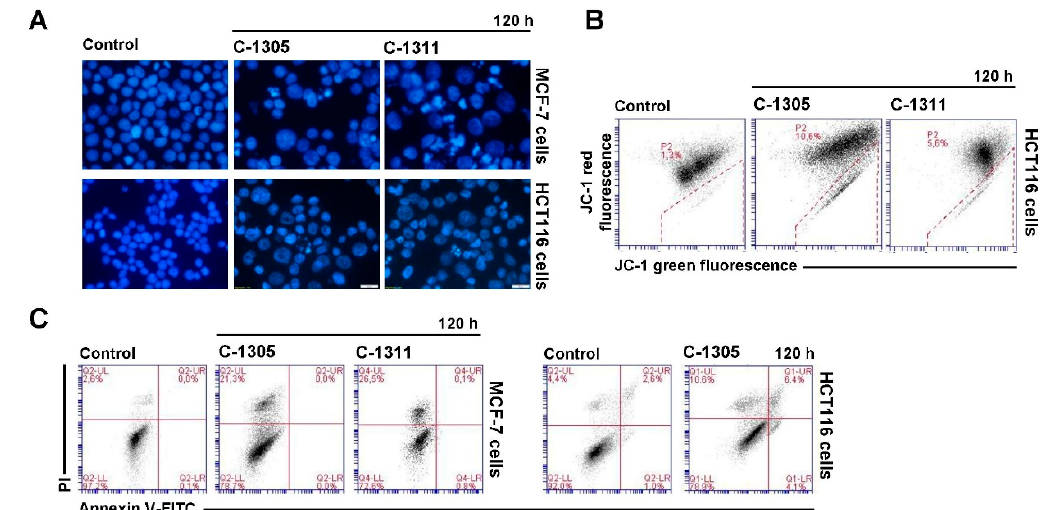
Figure 6. Cellular response of MCF-7-EV and HCT116-EV cells. ( A ) Representative pictures of changes in nuclear morphology of MCF-7 and HCT116 cells treated with IC 80 or IC 90 dosage, respectively, of C-1305 and C-1311 compounds. Cells were stained with 4 ′ ,6-diamidino-2- phenylindole (DAPI; 1 mg/mL) and visualized under fluorescent microscope (400× magnification); ( B ) Cytometric analysis of changes in mitochondrial transmembrane potential ( ΔΨ m) in MCF-7-EV and HCT116-EV cells treated with drugs for 120 h and labeled with JC-1 dye. Presented cytograms are representative of three independent experiments. Marked gates are populations of cells with decreased mitochondrial transmembrane potential ( ΔΨ m) (green fluorescence); ( C ) Phosphatidylserine externalization and membrane disruption in MCF-7-EV and HCT116-EV cells after 120 h of treatment with C-1305 and C-1311. Representative bivariate flow cytometry histograms of annexin V–fluorescein isothiocyanate (FITC) signal versus PI signal are shown. Bottom left quadrant represents live cells (annexin V negative, PI negative); bottom right quadrant represents early apoptotic cells (annexin V positive, PI negative); top right quadrant represents late apoptotic cells (annexin V positive, PI positive); top left quadrant represents primary necrotic cells (annexin V negative, PI positive).